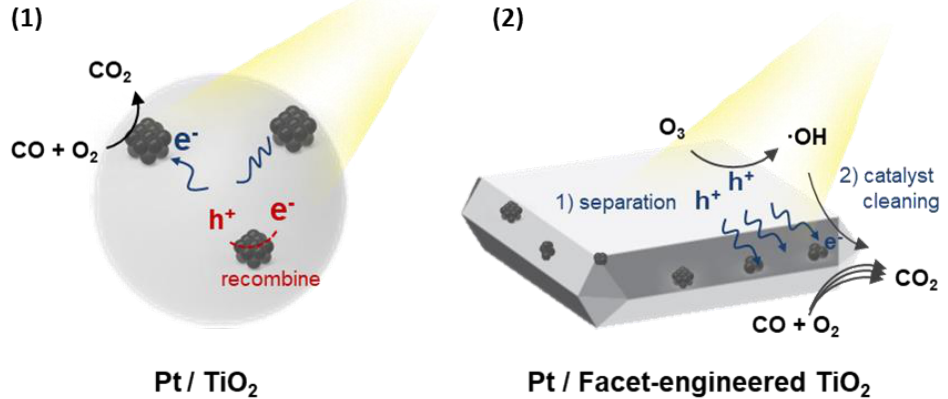
Figure 6. ( a ) Spin trap EPR of Pt/facet-engineered TiO 2 with/without exposure to O 3 . Experimental conditions: light source = UV LED; illumination time: 15 min; catalyst dose = 0.25 g/L; [DMPO] 0 = 30 mM; [O 3 ] = 124.3 ppbv. ( b ) In situ Diffuse Reflectance Infrared Fourier Transform Spectroscopy DRIFTS (In situ DRIFTS) for Pt/facet-engineered TiO 2 after three successive cycles of photocatalytic oxidation of CO. After exposing the sample to ozone flow with air for 1 min, 3 min, and 5 min. ( c ) XPS spectra and ( d ) XRD pattern of Pt 4f of Pt/facet-engineered TiO 2 , after 3rd photocatalysis cycle.